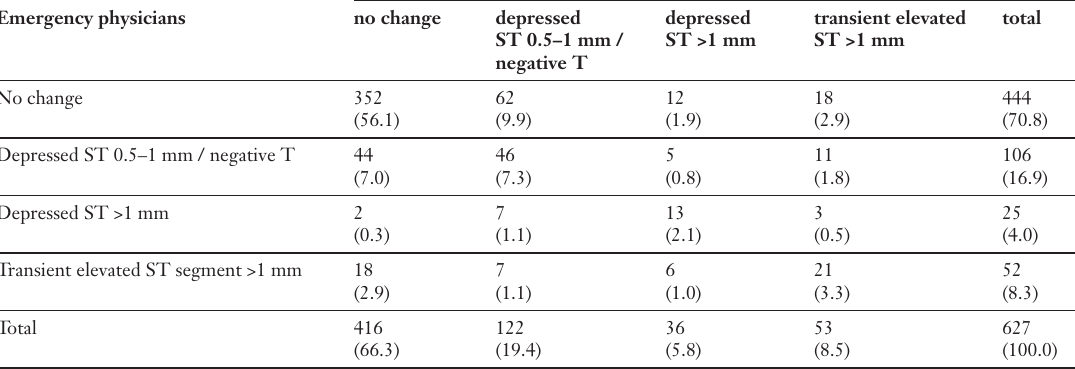
Importance of dis- crepancies between emergency physi- cians and final expert interpretation on patient risk stratifica- tion. Most of the discrepancies in ECG interpretation be- tween emergency room physicians and specialists were lim- ited to one category, except when the ECG was considered normal or when the ST segment was considered elevated.